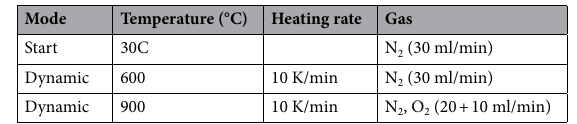
Table 1. Measuring parameters